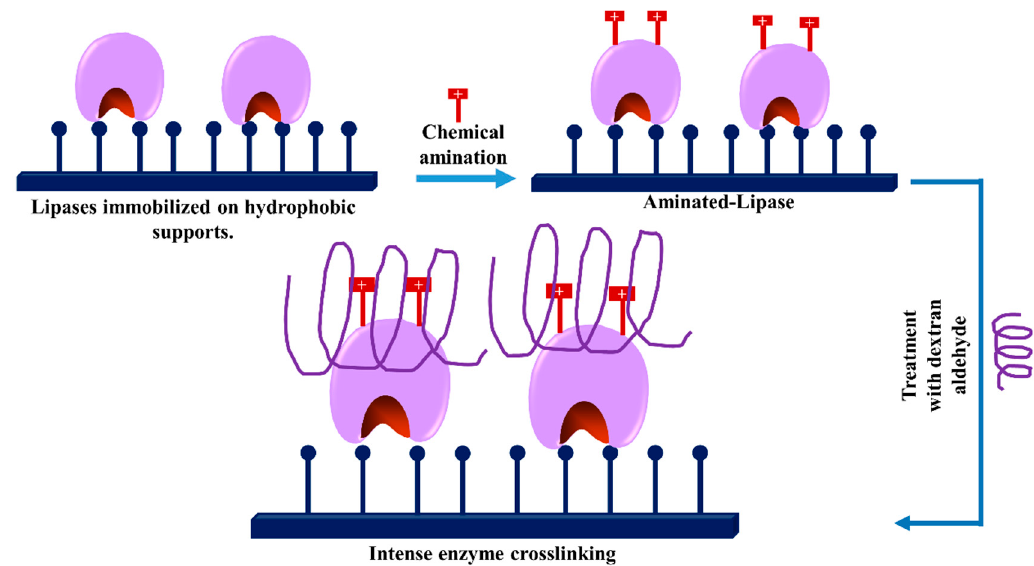
Figure 7. Stabilization of immobilized lipases by amination and further intense intramolecular crosslinking with dexOx.